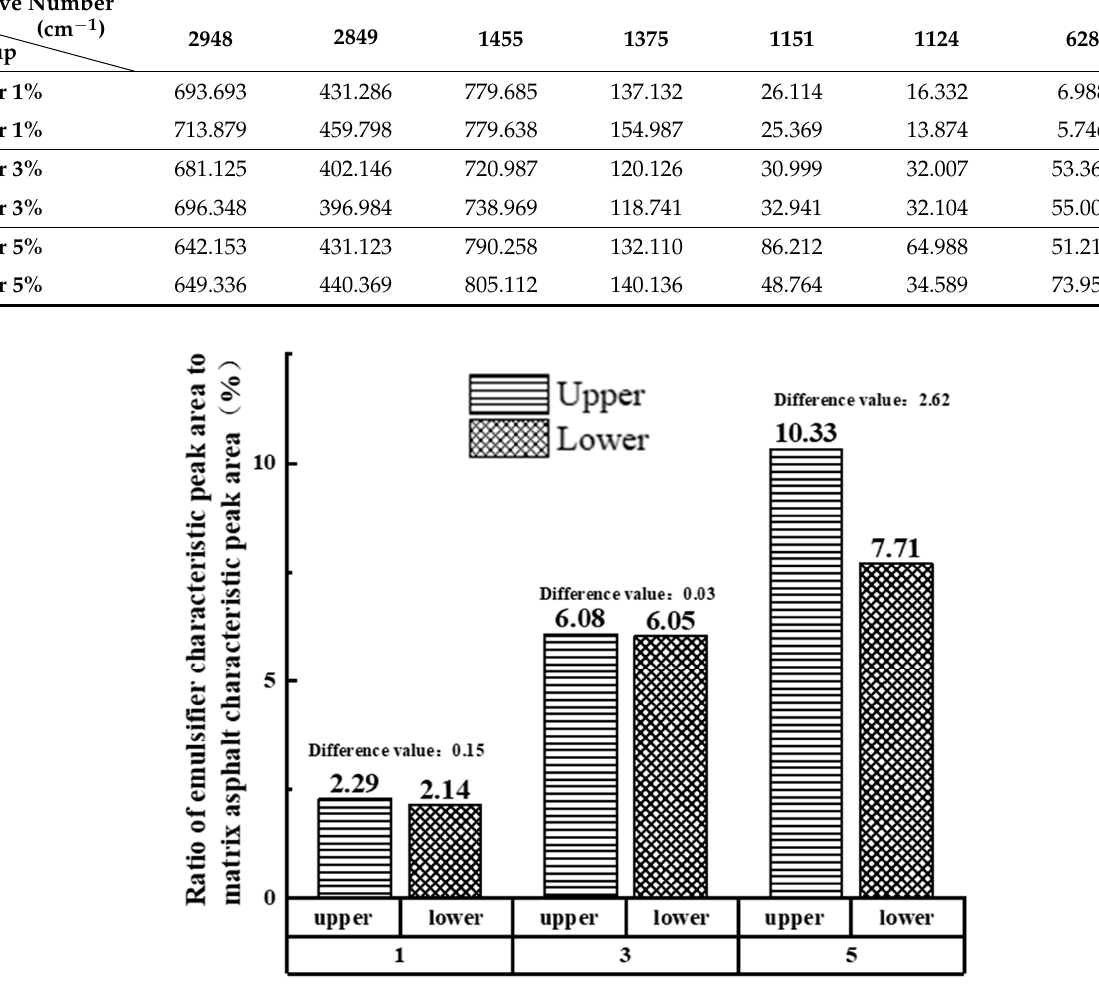
Figure 11. Proportion of emulsifier characteristic peak area in upper and lower branch tubes of storage-stabilized tubes.